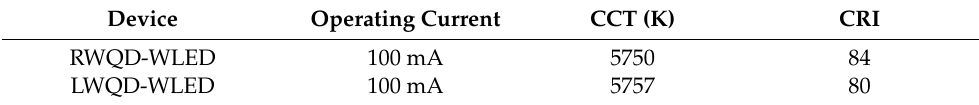
Figure 3. ( a ) RWQD-WLED emission spectra of the different currents and ( b ) LWQD-WLED emission spectra under different currents. ( c ) current-dependent integrated intensity of two types of devices. The insets in Figure 3a,b are the RWQD-WLED and LWQD-WLED lighting conditions. Table 1. The efficiency and CRI of two types of devices at current of 100 mA.